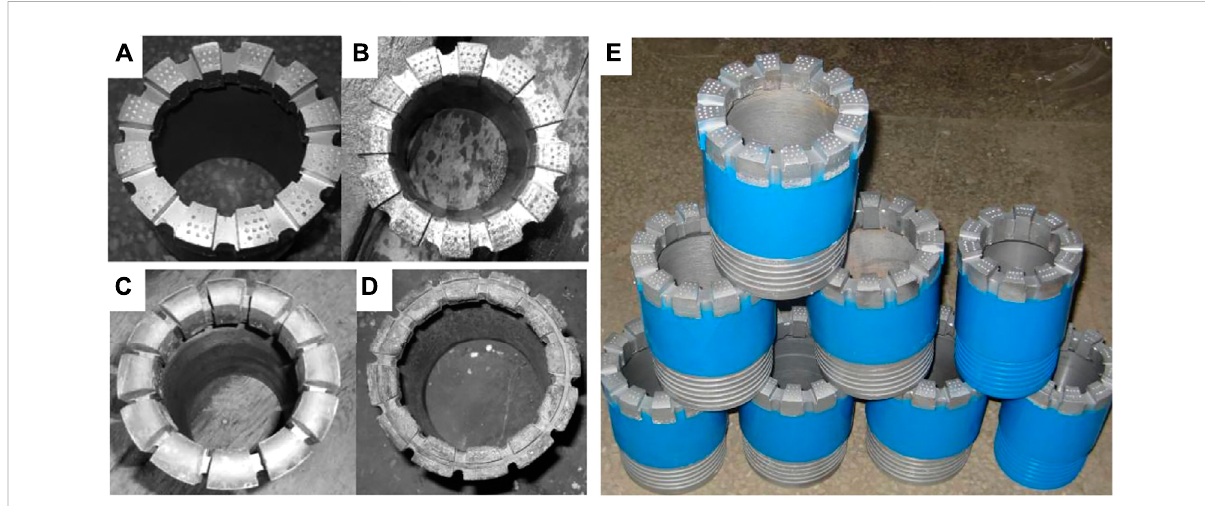
FIGURE 8 Bionic coupling impregnated diamond bit and normal diamond drill bit samples (modi fi ed from (Sun et al., 2012)). (A) A new bionic coupling impregnated diamond bit, (B) a used bionic coupling impregnated diamond bit, (C) a new normal diamond drill bit, (D) a used normal diamond bit, and (E) the front view of bionic coupling impregnated diamond bit